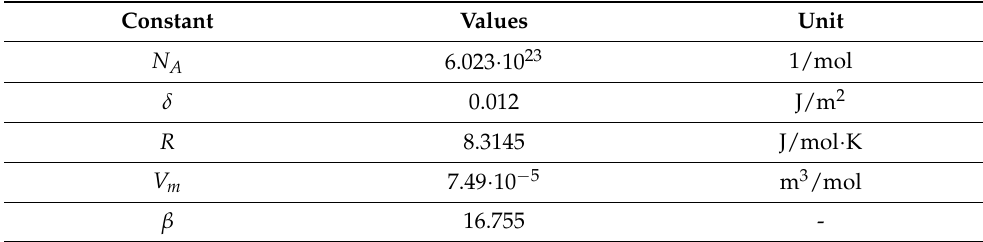
Table 8. Constants in equation on values B